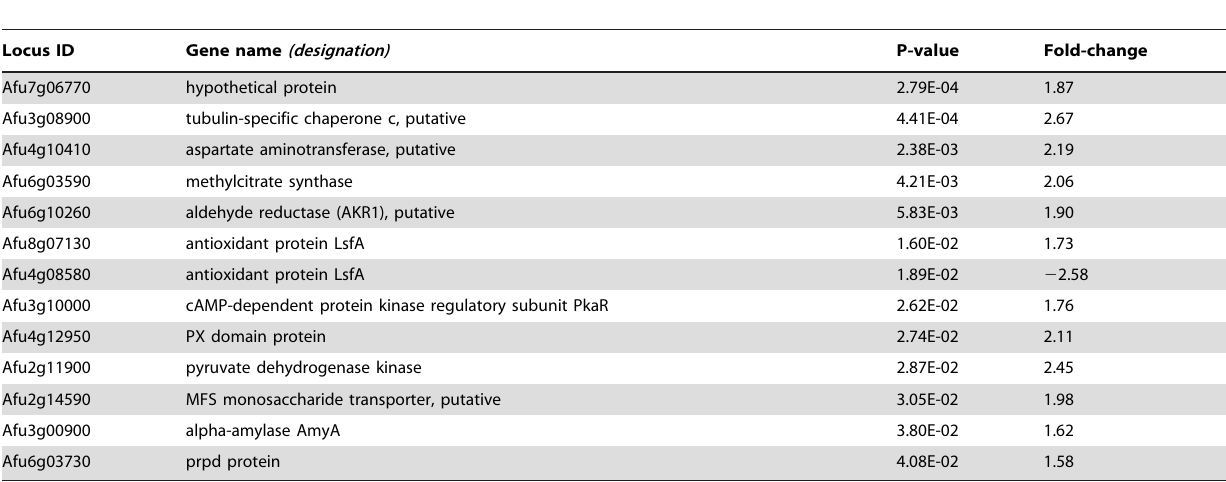
Table 3. List of A. fumigatus genes commonly identified by our study and by that of Sugui et al .